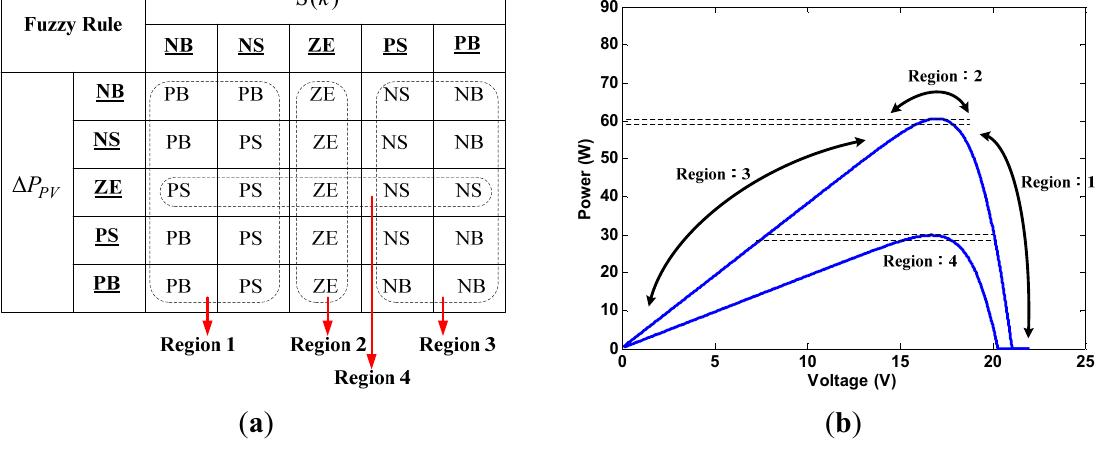
Figure 9. Fuzzy rules for P-V slope and variation of power as the inputs.